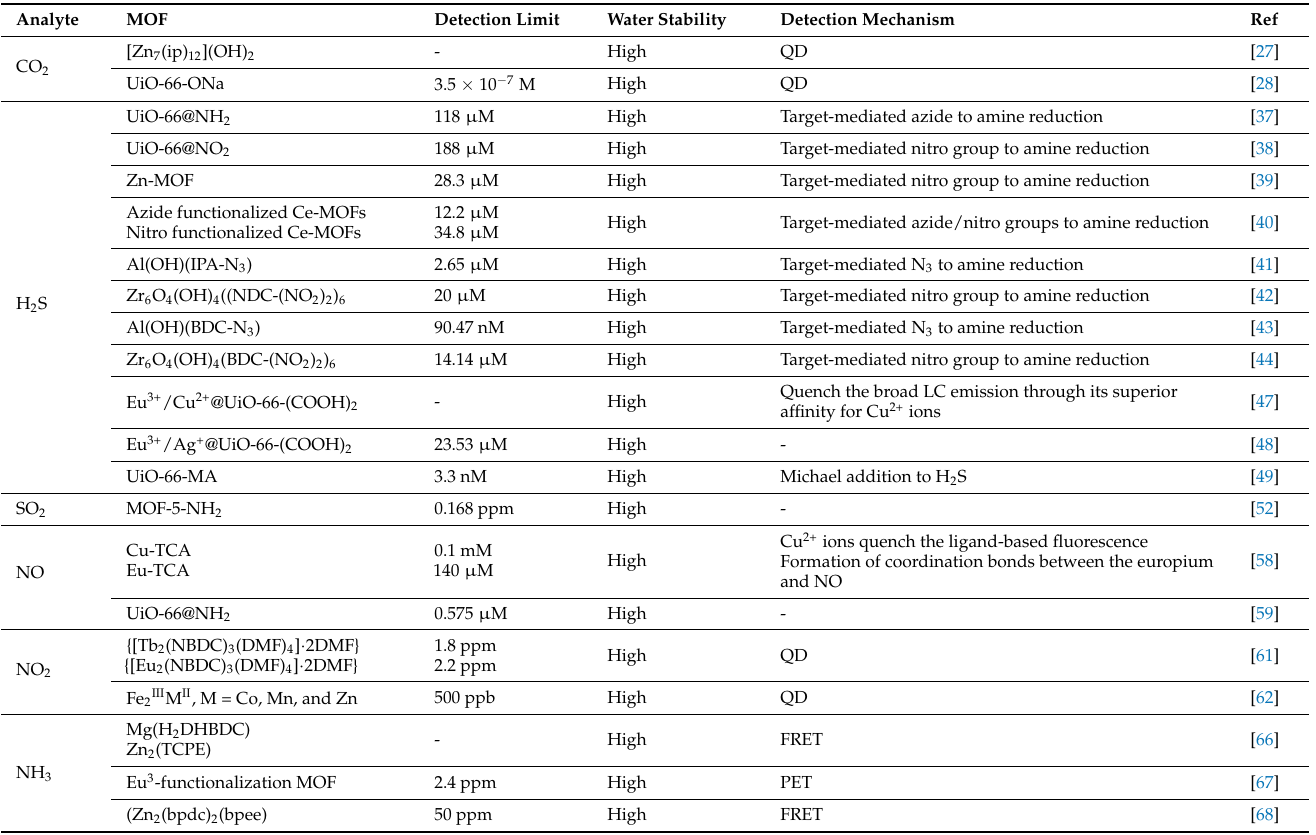
Figure 8. ( a ) The structure of 3D (Zn 2 (bpdc) 2 (bpee) and the schematic representation of the 2D structure potentially obtained after the NH 3 detection. ( b ) The luminescence intensity changes of (Zn 2 (bpdc) 2 (bpee) immersed in aqueous solutions of NH 3 with different concentrations. Adapted from [68]. Table 1. The gas detection ability and detection mechanisms of various LMOF-based